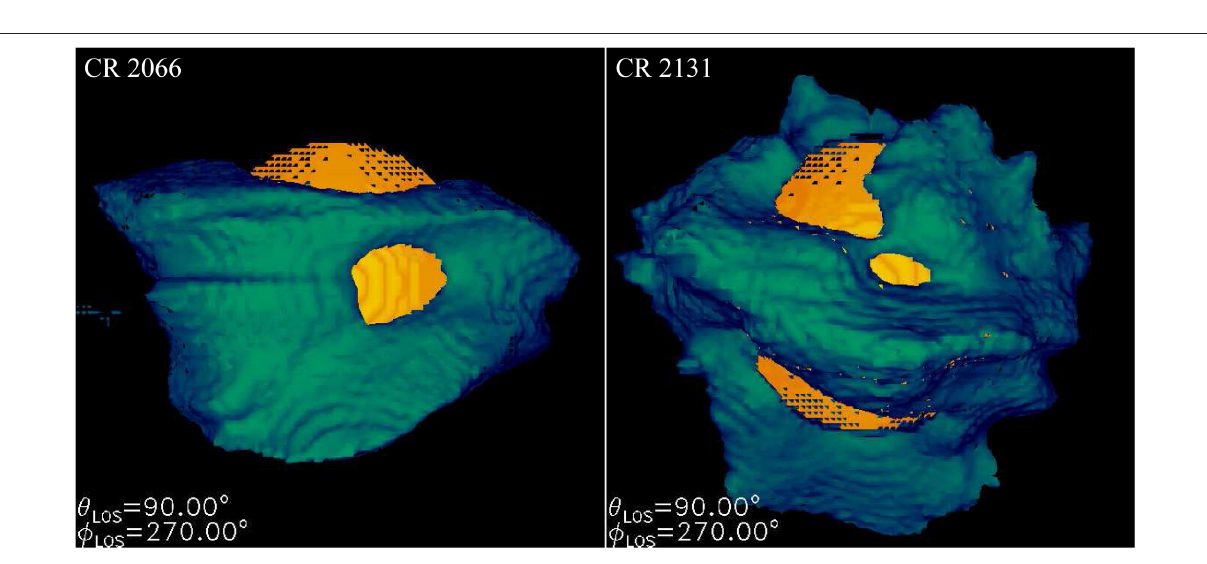
magnetograms collected over about a whole CR period while the tomographic reconstructions require observations over only half a CR period, the tomography provides more accurate description of the solar